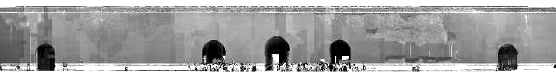
Figure8. Ortho-image of the north wall